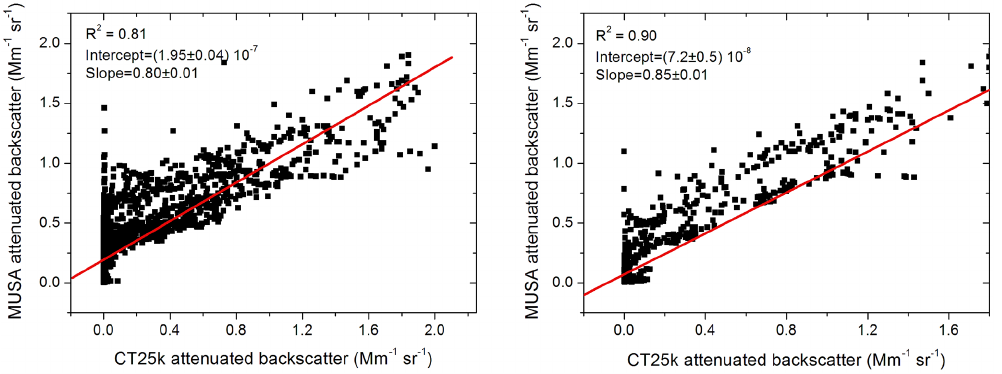
Figure 4. Scatterplot of the attenuated backscatter coefficient retrieved by the ceilometer CT25K observations vs. the attenuated backscatter coefficient retrieved by MUSA observations; the right panel shows the same plot including only cases from 2 September 2013 onwards when air temperatures were generally cooler.